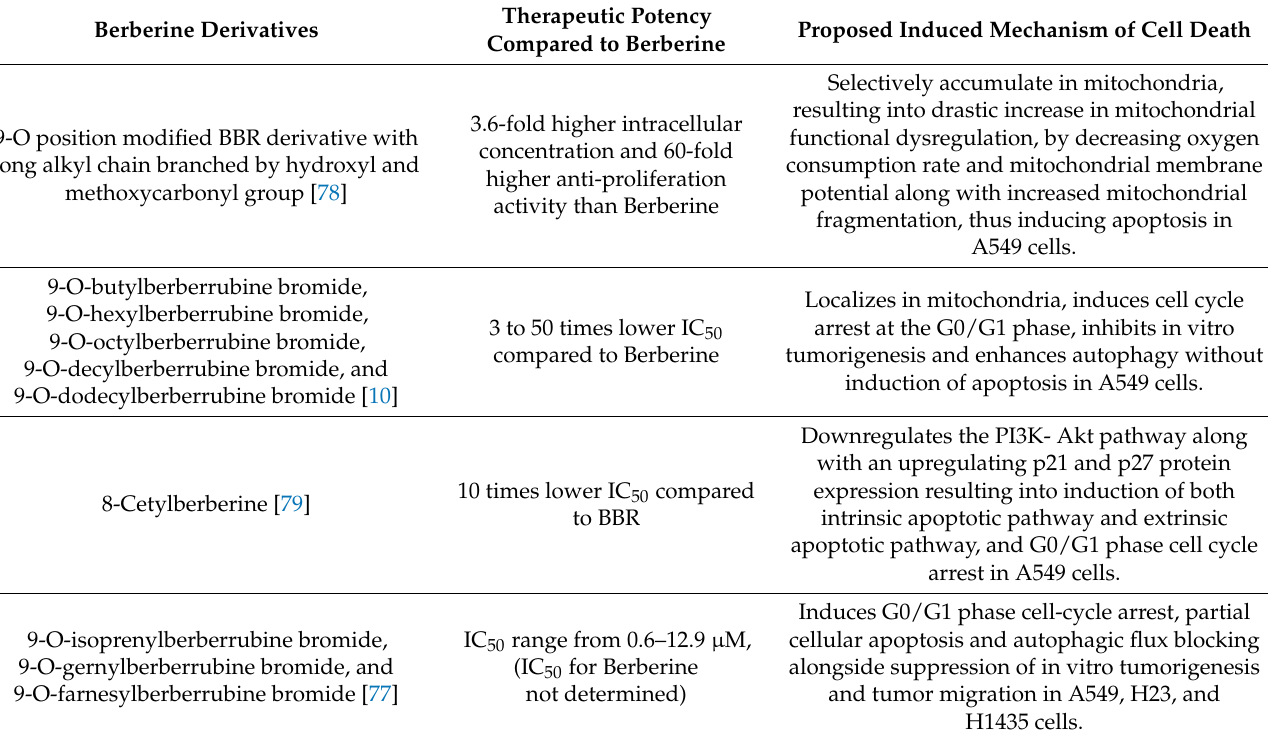
Table 1. Comparison of therapeutic potential and induced mechanisms of various Berberine deriva- tives against in vitro lung cancer